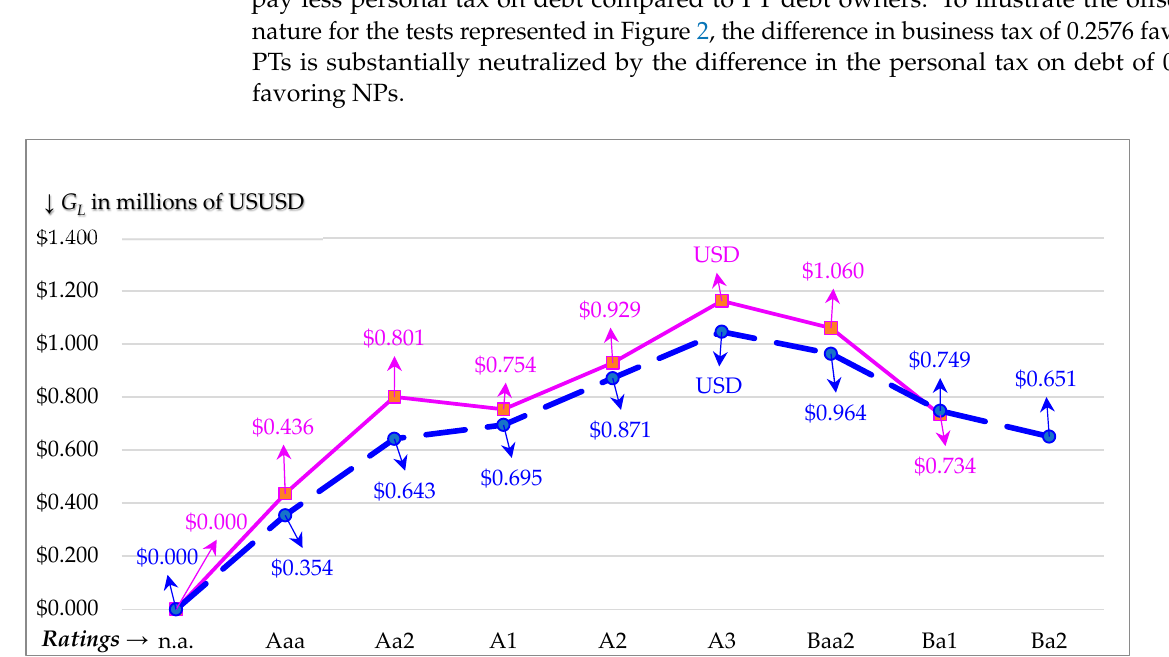
22 of 43 Figure 1. P choices are plotted along vertical axis against Moody’s credit ratings along horizontal axis. P is debt divided by unlevered equity value. The nonprofit trajectory is the solid line and the pass-through trajectory is the dashed line. We use credit spreads for 2019, TCJA low ( L ) tax rates, and 3.12% growth where the growth ( RE ) constraint sets in after Ba1 for